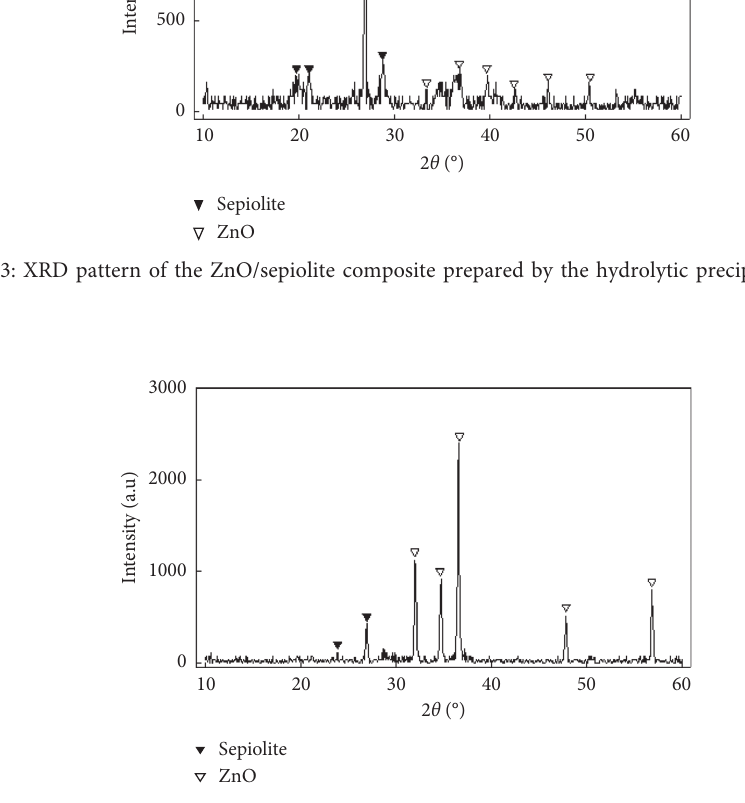
Figure 24: XRD pattern of the ZnO/sepiolite composite prepared by the powder sintering